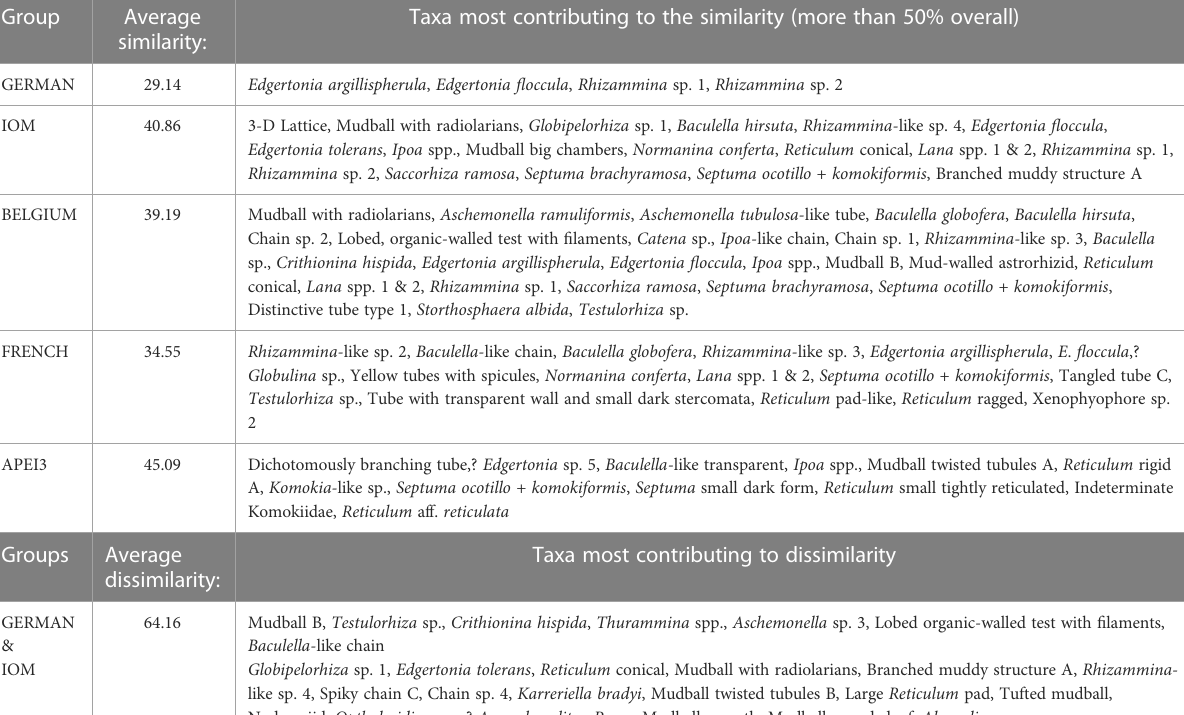
Distinctive tube type 1, Storthosphaera albida , Testulorhiza